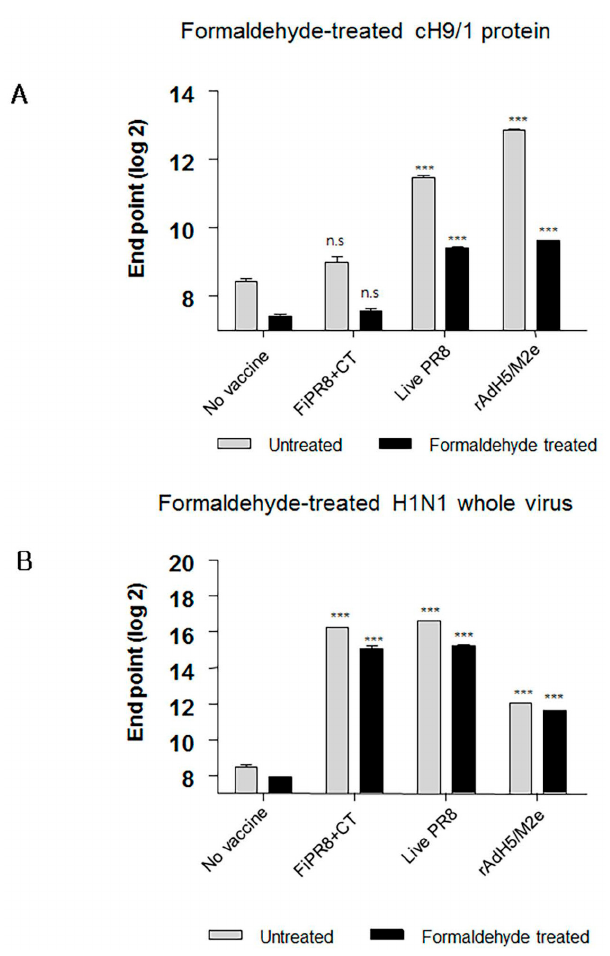
Figure 6. Formaldehyde treatment specifically reduces antigenicity of the HA stalk. To examine whether formaldehyde treatment alters the antigenicity of the HA, immune sera were examined by ELISA with formaldehyde-treated or untreated baculorvirus-expressed cH9/1 protein ( A ) or with formaldehyde-treated or untreated H1N1 whole virus particles ( B ). The values represent the mean ± SEM (vertical bars) end point ELISA antibody titers determined from five mice per group. The data represent results from three independent experiments (*** p < 0.0001). Viruses 2017 , 9 , 234